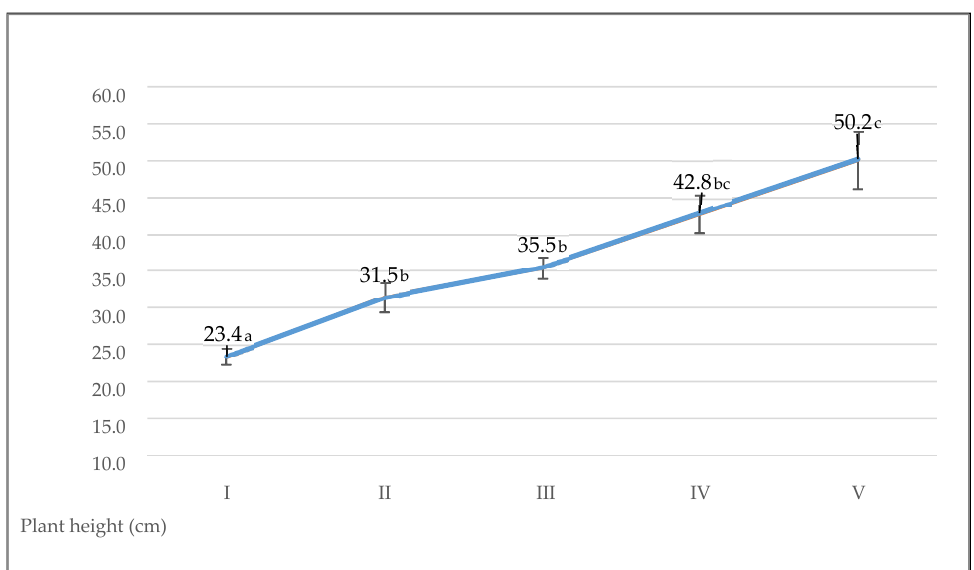
Figure 3. Camelina sativa plant height evolution (average between the two test years). I: main stem elongation; II: maximum stem elongation: III: inflorescence appearance; IV: flowering; V: fruit set visible. Means with different lower-case letters are significantly different at p < 0.05.